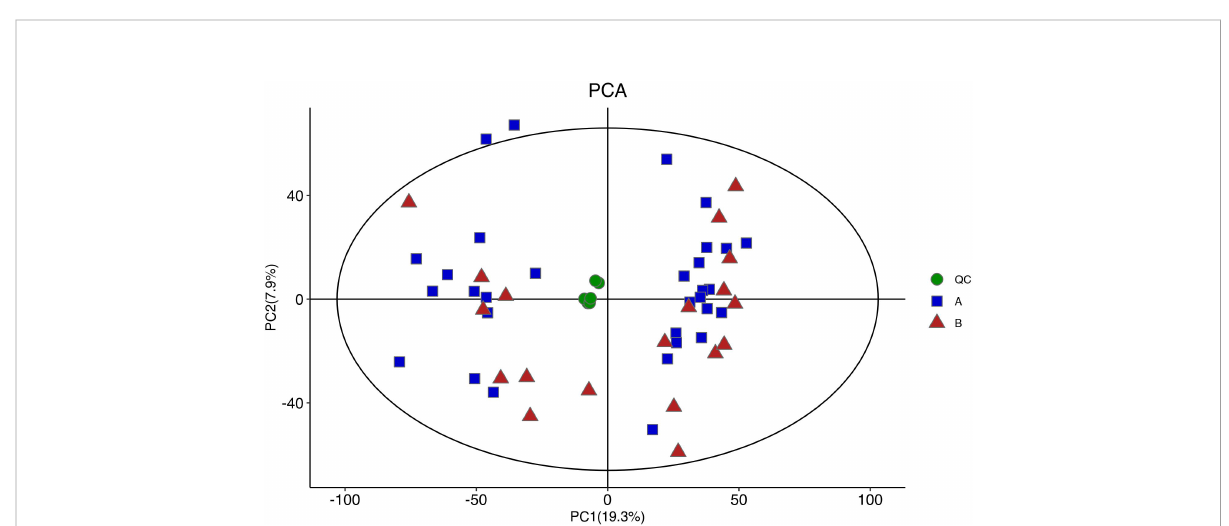
FIGURE 4 A PCA diagram of the samples used for analysis (including QC). QC samples were closely clustered in the middle of all samples, and no outlier samples were found, indicating good stability of instrumental analysis system and stable and reliable experimental